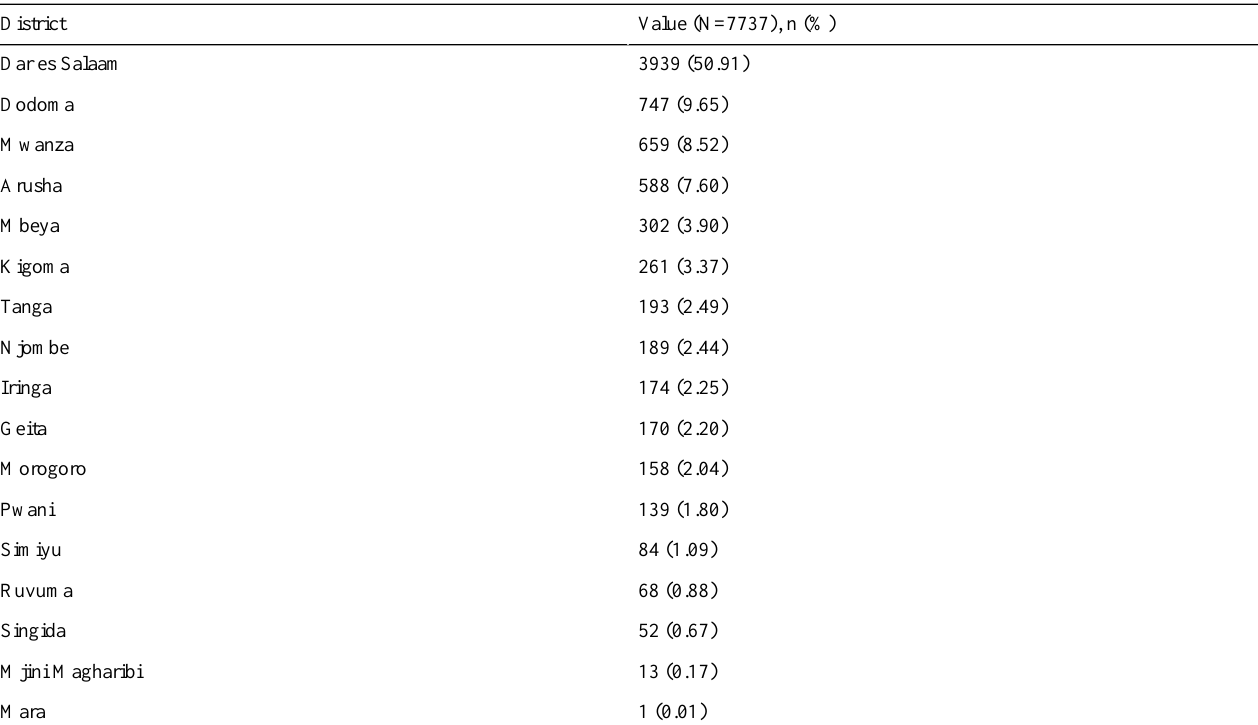
Table 2. Frequency of wards requested per district in Tanzania from September 2013 to August 2016.